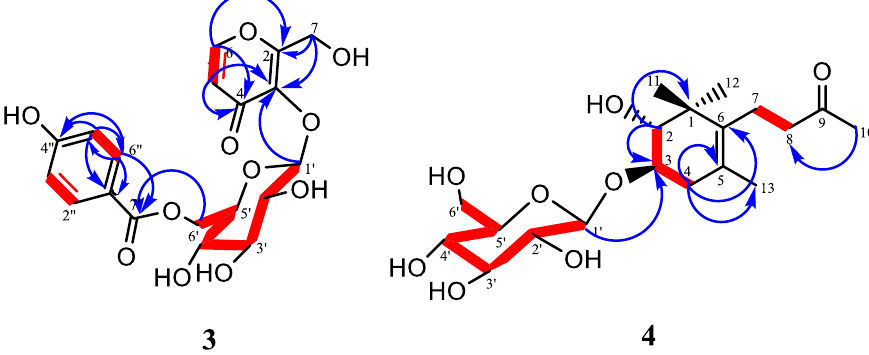
Figure 3. Key HMBC ( → ) and COSY ( — ) correlations of compounds 3 and 4 . Compound 4 was obtained as white crystals. The molecular formula was established as C 19 H 32 O 8 by the positive-ion HRESI-MS, which showed a molecular ion [M+H] + at m / z 389.2177 (calc. for 388.4615). The IR spectrum of 4 showed absorption bands characteristic of a hydroxyl group (3179 cm − 1 ), conjugated ester (1693 cm − 1 ), α , β -unsaturated carbonyl (1633 cm − 1 ), and aromatic C=C (1600 cm − 1 ) functionalities. The 1 H NMR spectrum (Table 2) showed signals of two tertiary methyl protons at δ H 0.86 (3H, s , H-12), 1.01 (3H, s , H-11), a vinyl methyl at 1.56 (3H, s , H-13), and an acetyl methyl at δ H 2.07 (3H, s , H-10). Three methylene protons were observed resonating at δ H 2.00 (1H, dd , J = 17.4, 6.4 Hz, H-4a), 2.31 (1H, dd , J = 17.4, 6.4 Hz, H-4b), 2.09 (1H, m , H-7a), 2.16 (1H, m , H-7b), and 2.45 (2H, t , J = 8.1 Hz, H-8). In addition, two oxymethine protons appeared at δ H 3.16 (1H, m ) and 3.70 (1H, m ) and were attributed to H-2 and H-3, respectively. Another resonance appeared at δ H 4.28 (1H, d , J = 7.8 Hz) for the anomeric proton; the J coupling constant was consistent with a beta anomeric proton. The remaining sugar resonances appeared as a cluster between δ H 3.0 and 3.70. The 13 C and DEPT-135 NMR spectra (Supplementary Material) showed that compound 4 had 19 carbon